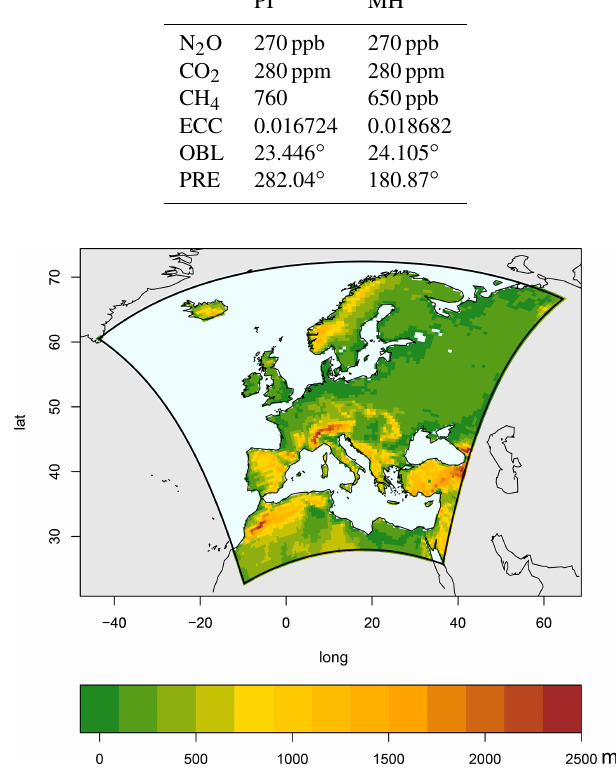
Figure 1. Map of the topography and extension of the model do-